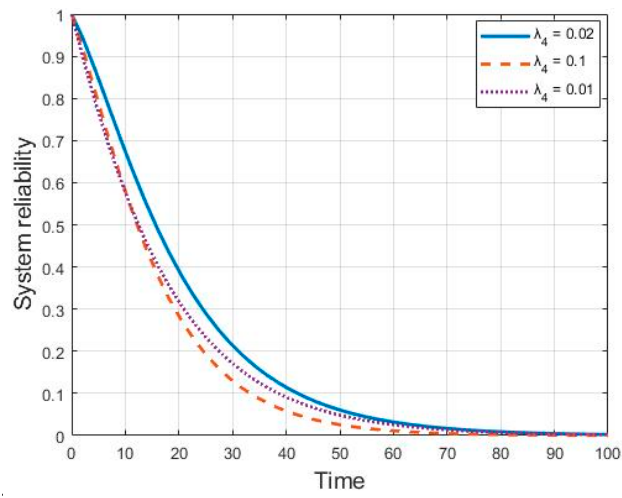
Figure 4. System reliability comparison with the changes of degradation rate 𝜆 (cid:2869) .